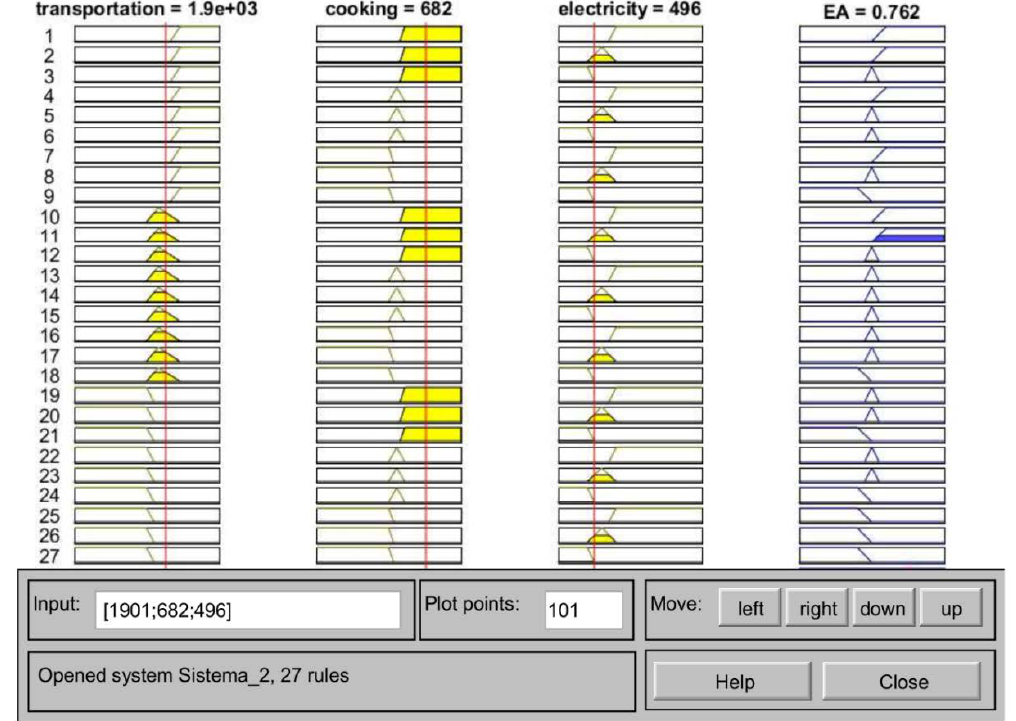
Figure 8. MATLAB screen results. Evaluation of the rules and their results to determine energy access.